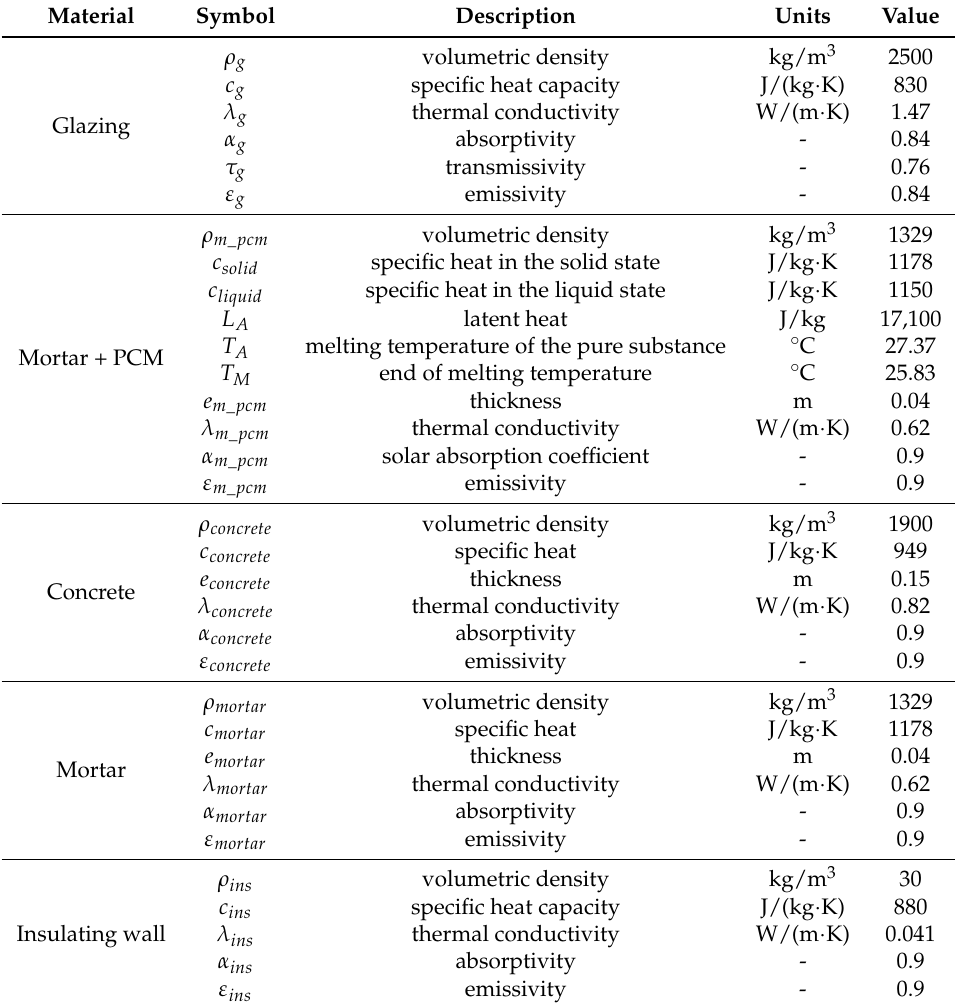
Table 4. Thermal properties of the construction materials used in the solar Trombe